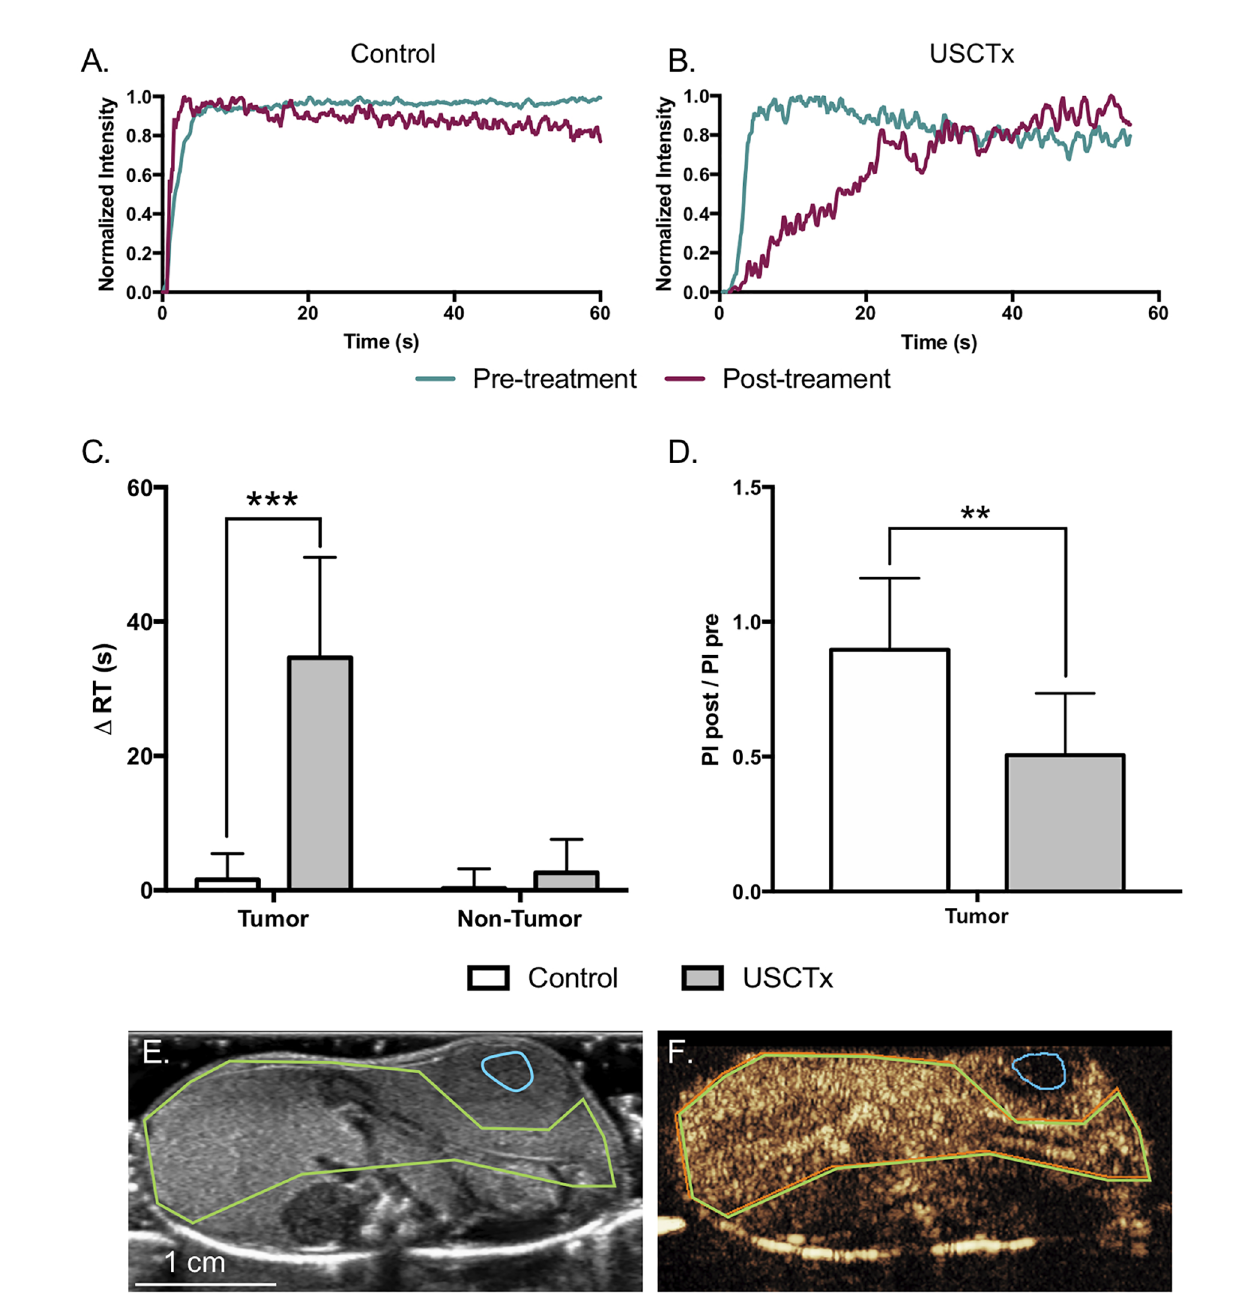
FIGURE 6 | Representative TICs from control (A) and USCTx (B) mice within the tumor. Signal intensity was normalized to the maximum intensity in each individual ROI in order to better visually demonstrate change in time parameters as in Figure 3 . Quanti fi cation of D RT in control and USCTx mice in the tumor and non-tumor liver is shown in (C) . Post-treatment PI divided by pre-treatment PI within the tumor is shown in (D) . ROIs showing the tumor (blue) and non-tumor tissue (green) is shown in b-mode (E) and contrast (F) . **p < 0.01, ***p <